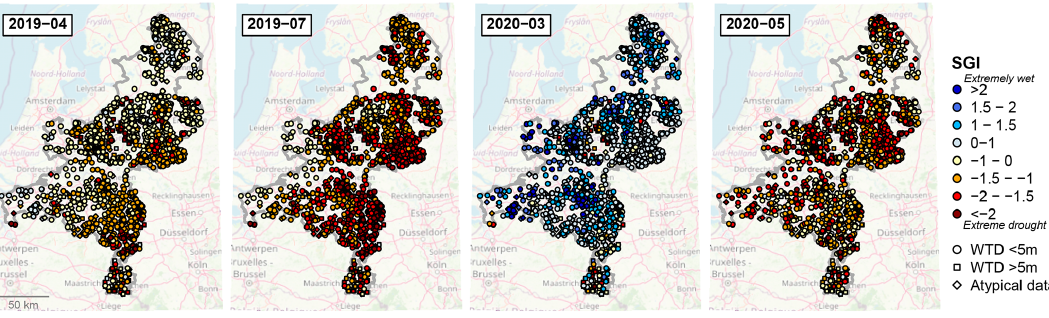
Figure 6. Groundwater drought over 2019–2020: SGI of extended groundwater series for April, July, March, and May 2019–2020. WTD denotes water table depth.